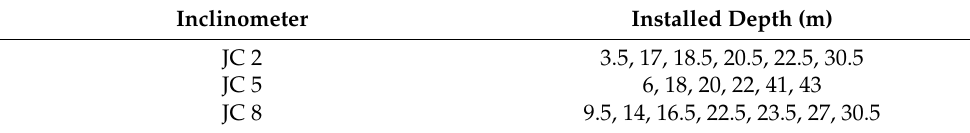
Table 2. Installed depth of the fixed